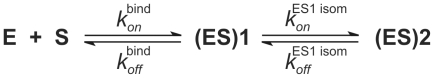
The kinetic scheme describing the interactions of APE1K98A with undamaged ligand.